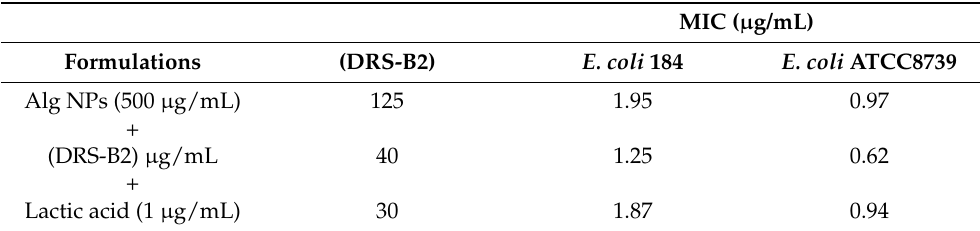
Table 5. MICs of the formulation Alg NPs + DRS-B2 supplemented with lactic